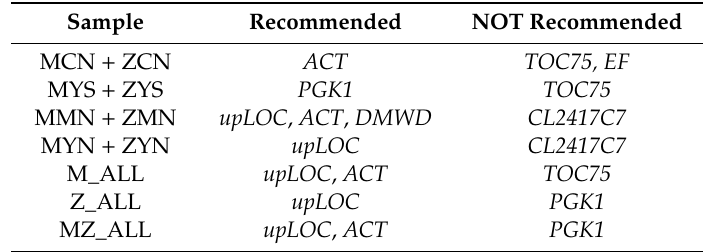
Table 3. The recommended and NOT recommended reference genes for each tissue type / species. Sample Recommended NOT Recommended MCN + ZCN ACT TOC75, EF MYS + ZYS PGK1